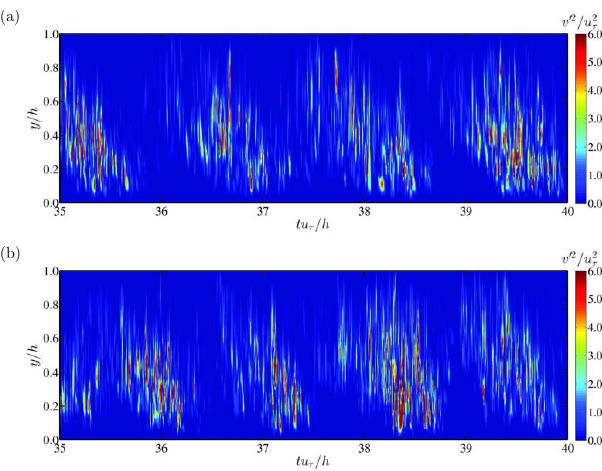
Figure 6. Time height plots of square of instantaneous vertical velocity ( v (cid:48) 2 ) in the channel ( Re τ = 180). (a) Ri τ = 120, and (b) Ri τ =